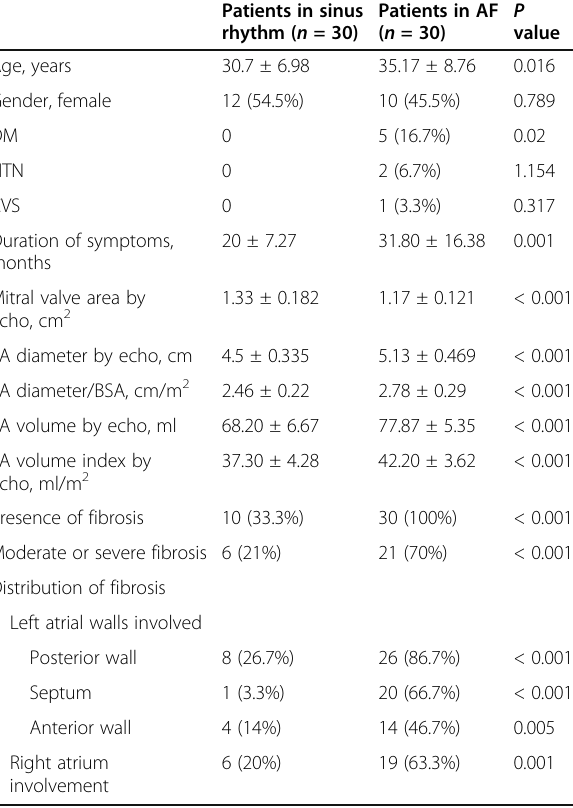
Table 1 Baseline echocardiographic and MRI data Variable